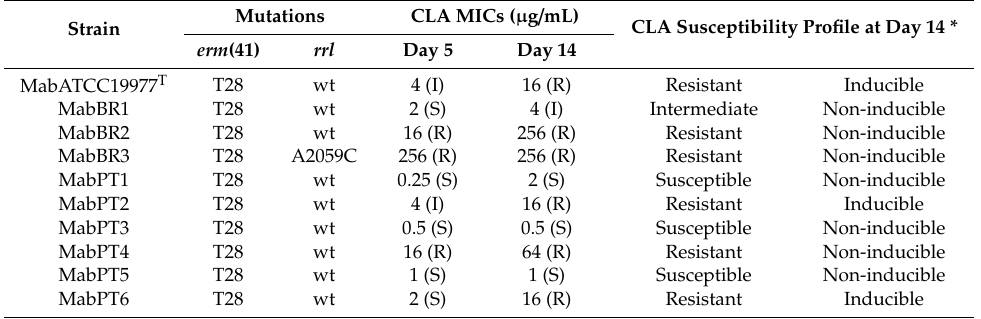
Table 2. Analysis of inducible vs. non-inducible clarithromycin resistance in the M. abscessus strains